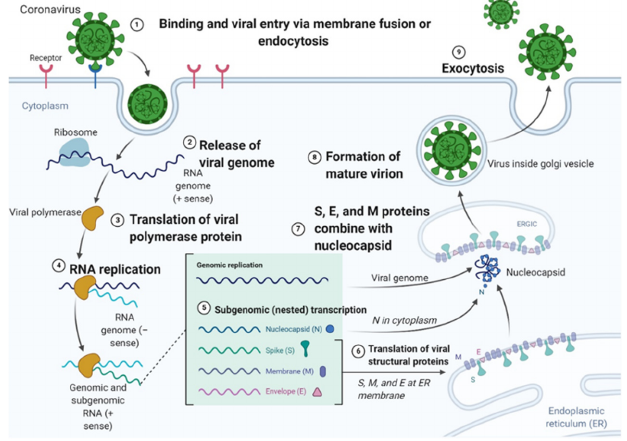
Figure 1. Schematic illustration of the coronavirus entry and replication cycle within the human host. (Image modified from BioRender Templates, also found in